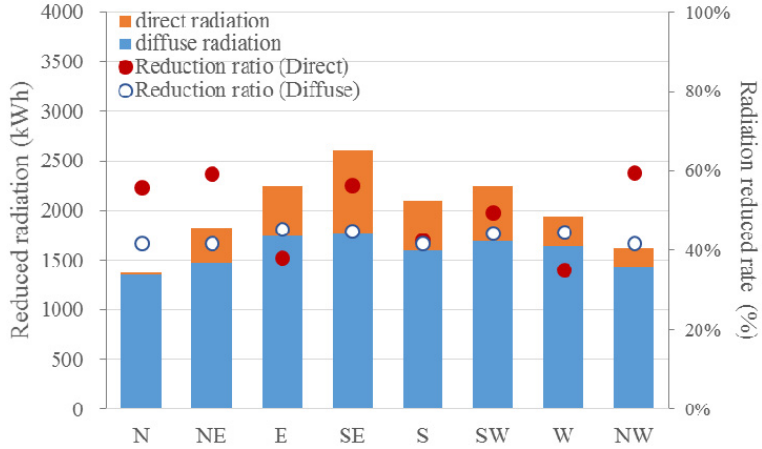
Figure 10. Annual total reduced solar radiation in various facing orientation with